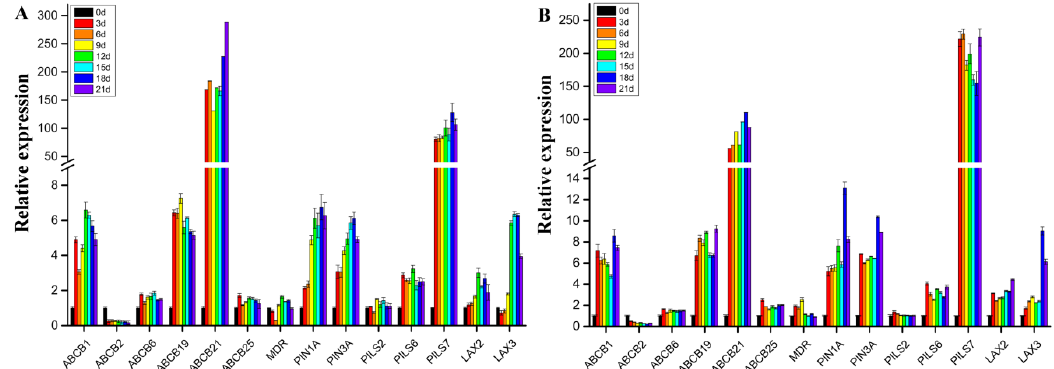
Figure 7. Expression pattern analyses of 14 genes involved in polar auxin transport in somatic embryo induction media under darkness ( A ) or light ( B ) for different durations.